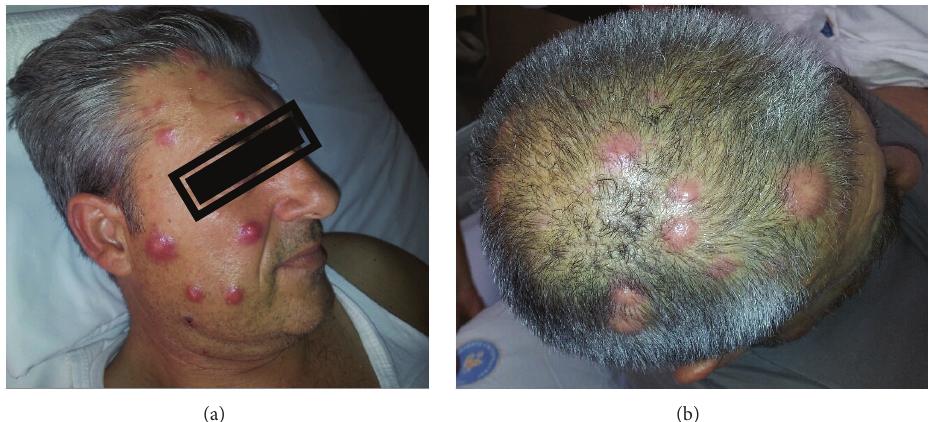
Figure 1: Large number of bulky, hyperemic nodules on the (a) face and (b) scalp.